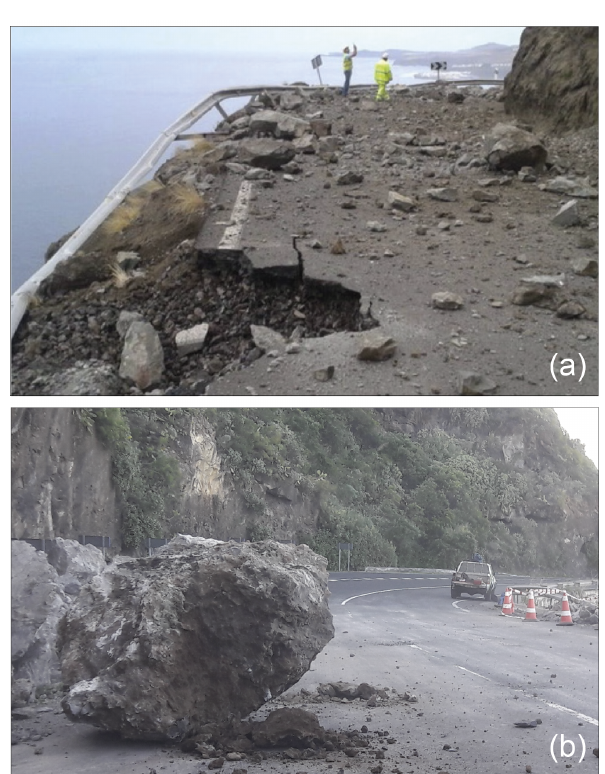
Figure 2. Photos of rockfalls at the GC (a) and TEN (b) test sites (credits: R. M. Mateos and S. Leyva